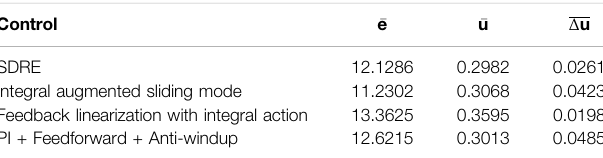
TABLE2| Performanceofcontrolstrategies:experimentalresultsforsquarewave with T = 2 s. Control